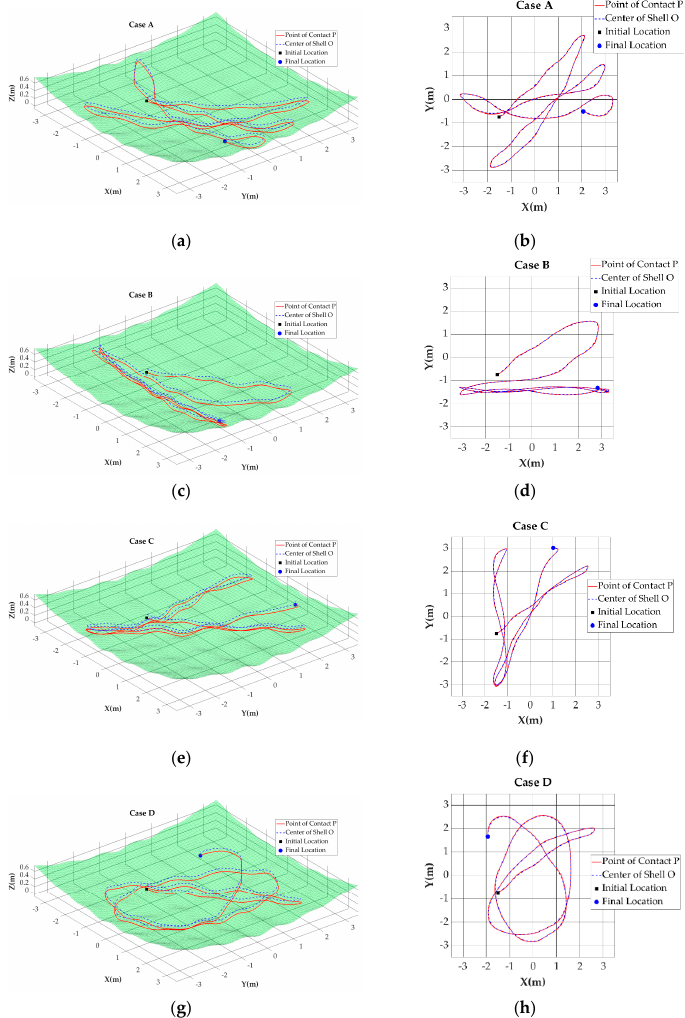
Figure 5. Example 1. Path taken by the point of contact P and the center O plotted in 3D space on the left and its projection on the horizontal XY plane on the right. ( a , b ) Case A, ( c , d ) Case B, ( e , f ) Case C, ( g , h ) Case D.